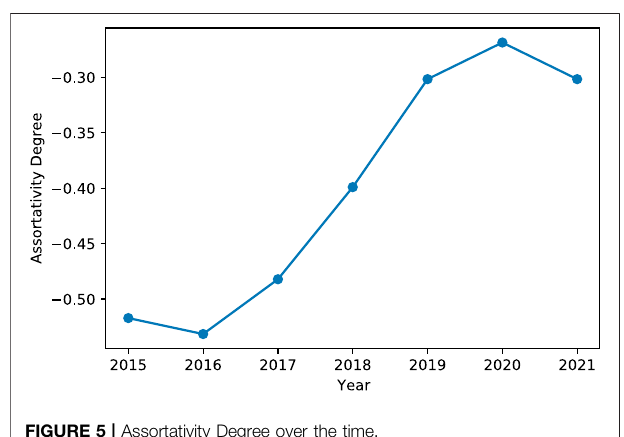
FIGURE 5 | Assortativity Degree over the